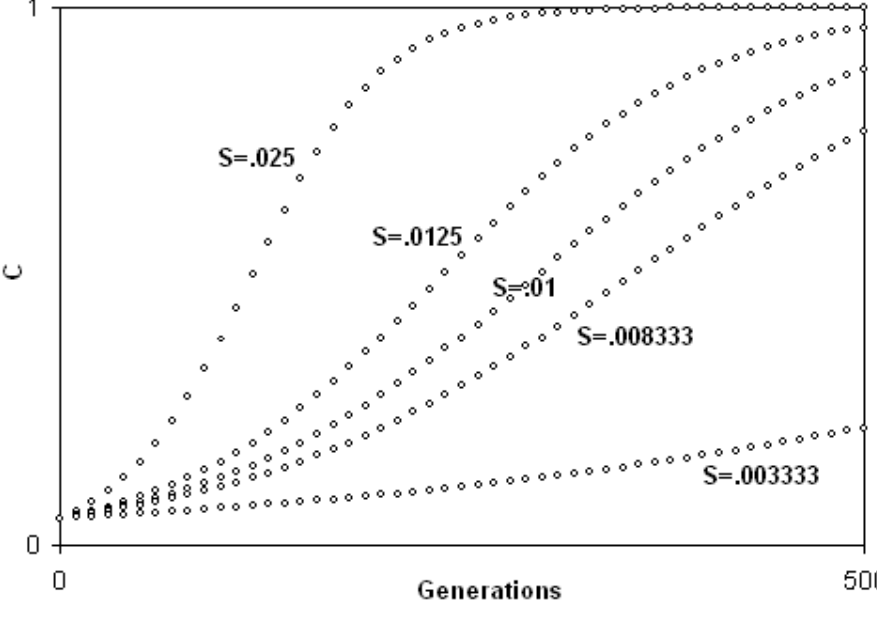
FIGURE 6. Spreading of a gene (C) according to the variation of S. The ML, that determines the rate of generation turnover, has a constant value (= 1) for all the five curves. Going from top to bottom, the values of S (arbitrarily chosen) are: S 1 = 0.025; S 2 = 0.0125; S 3 = 0.01; S 4 = 0.008333; and S 5 = 0.003333. Moreover: C o = 0.05. (This and the following figure are reprinted from